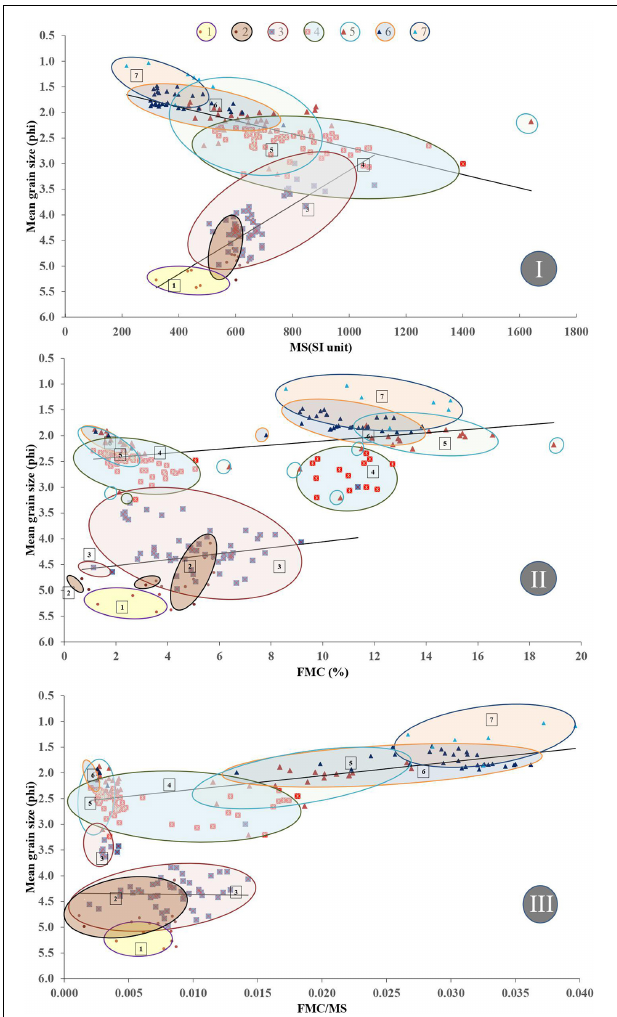
FIGURE 7 | Cross plots FMC, MS, and Facies. (I) MS vs. Mean grain size showing two distinct trends in fine facies and sandy facies. (II) FMC vs. Mean grain size showing two similar trends in fine facies and sandy facies. (III) FMC/MS vs. Mean grain size showing two similar trends in fine facies and sandy facies. Coloured circles envelopes similar sediment